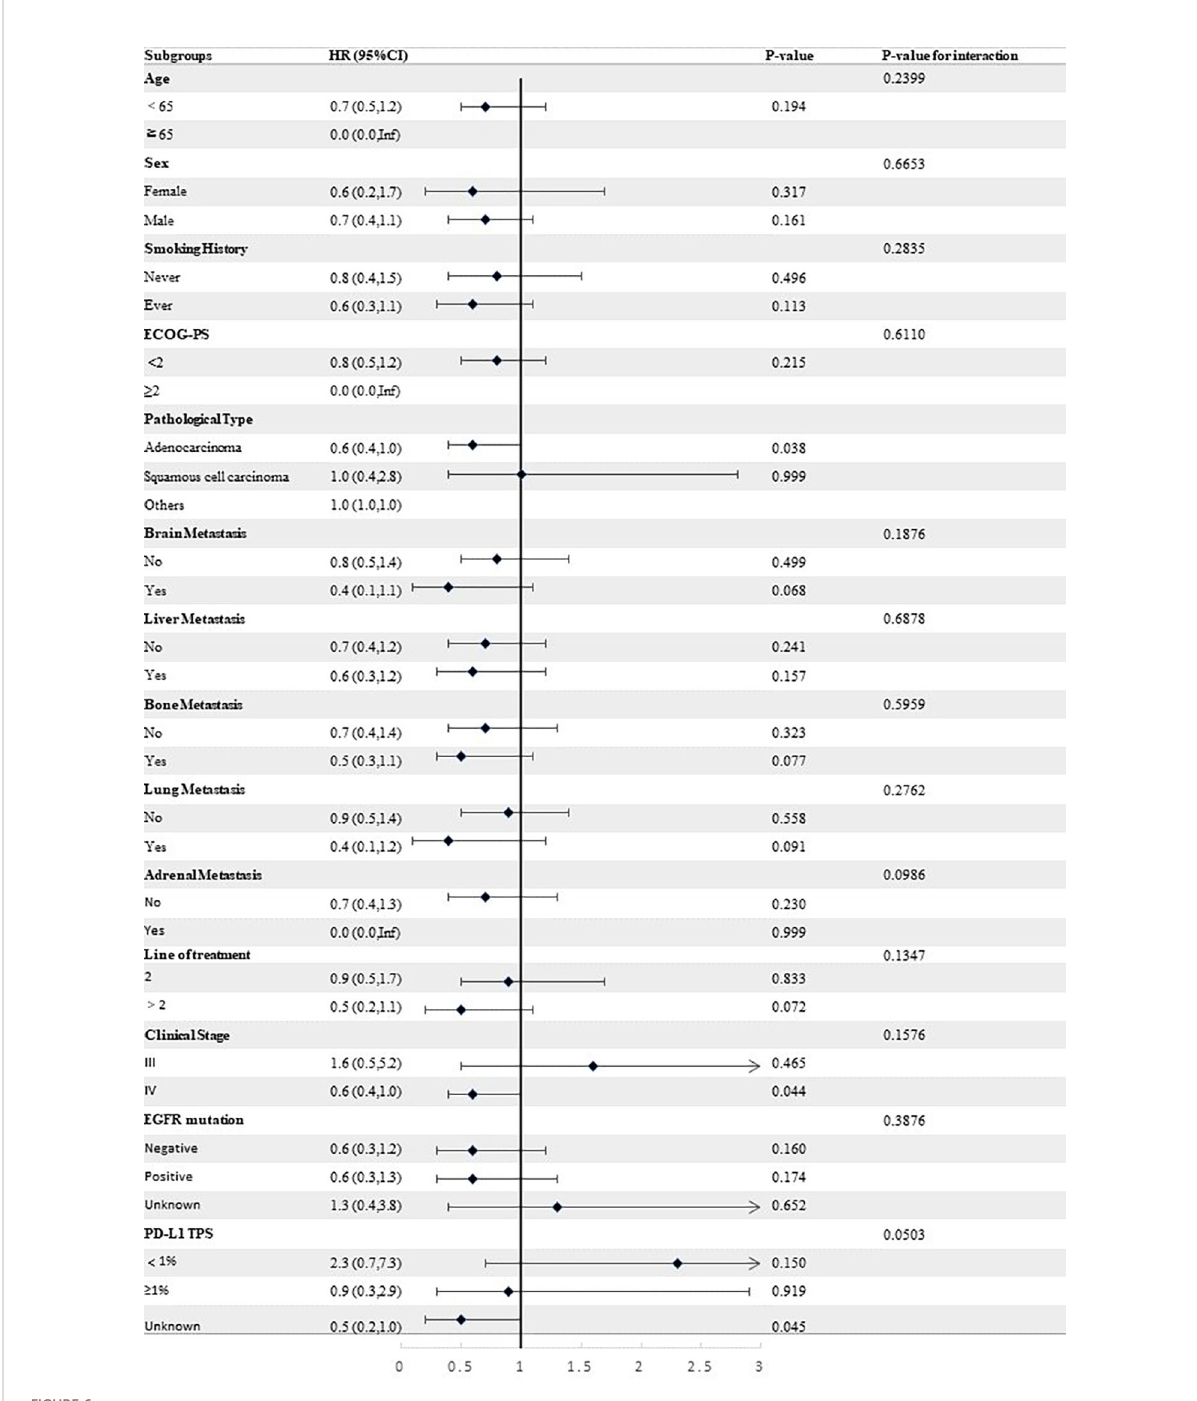
FIGURE 6 Forest plot of risk of death for patients in PA group compared to PC group in different